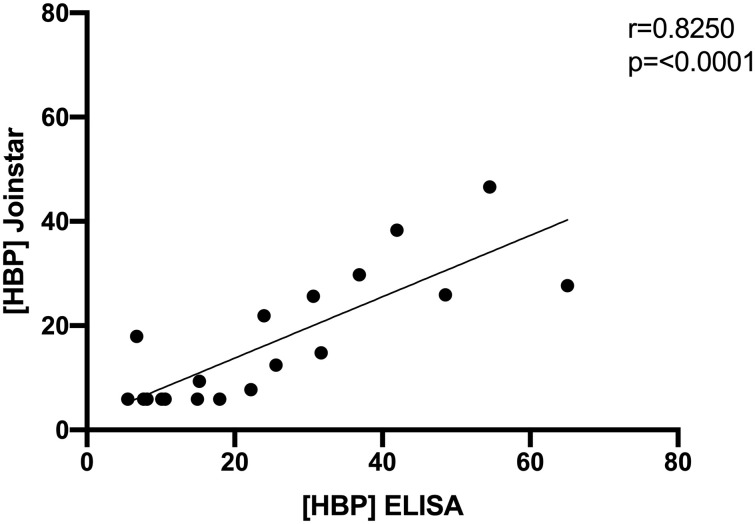
Correlation between ELISA and Joinstar values.Correlation of HBP levels in the same samples measured by Joinstar point of care device and ELISA. Correlation coefficient R = 0.8250; p<0.01). Values were compared using Spearman correlation.